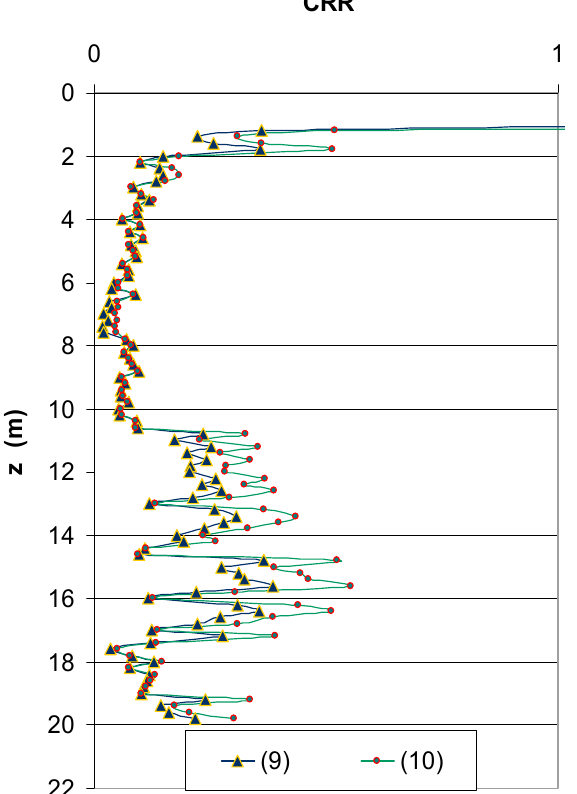
Figure 9. CRR with depth, from K d data from SDMT test A, at Scortichino test site.